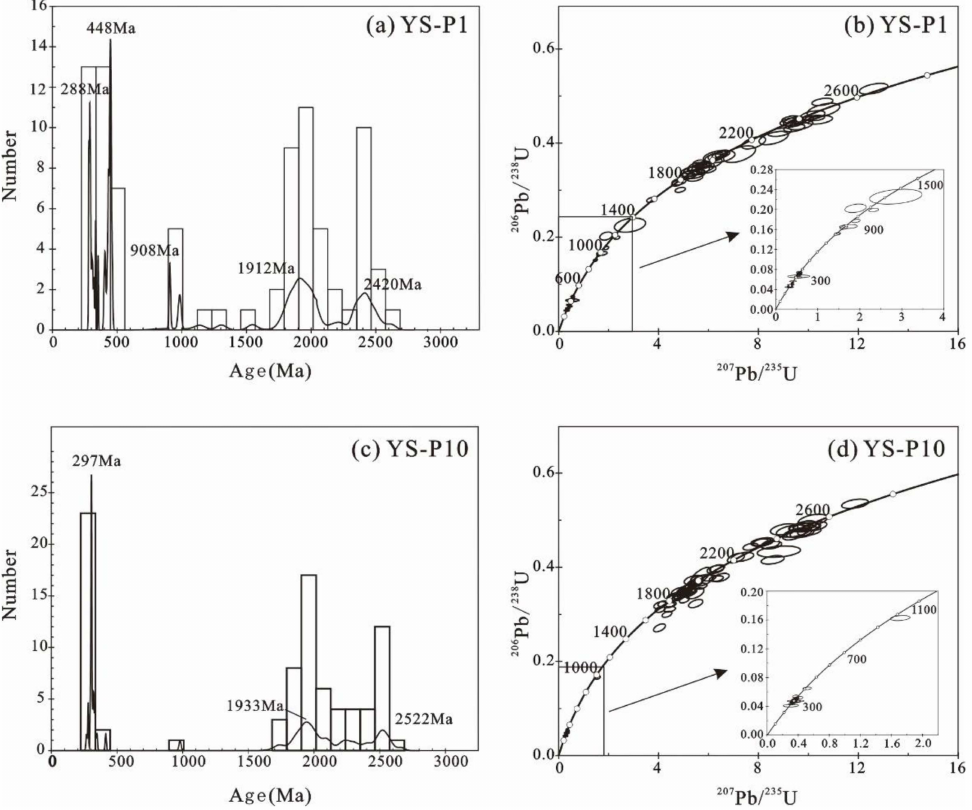
Figure 4. Results of detrital zircon U-Pb age histograms and concordia diagrams. ( a ) YS-1 histograms of U–Pb ages; ( b ) YS-1 concordia diagrams; ( c ) YS-10 histograms of U–Pb ages; ( d ) YS-10 concordia